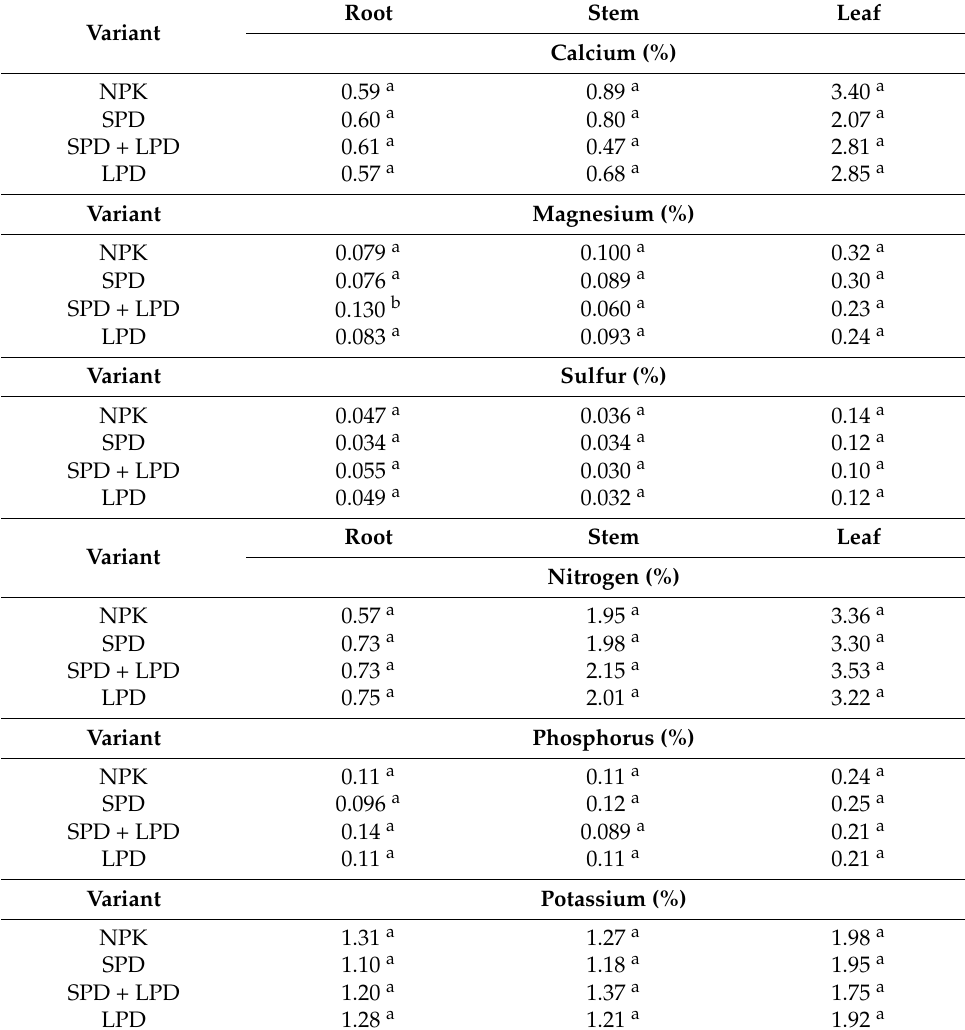
Table 7. Macronutrient contents in individual parts of cannabis in dry